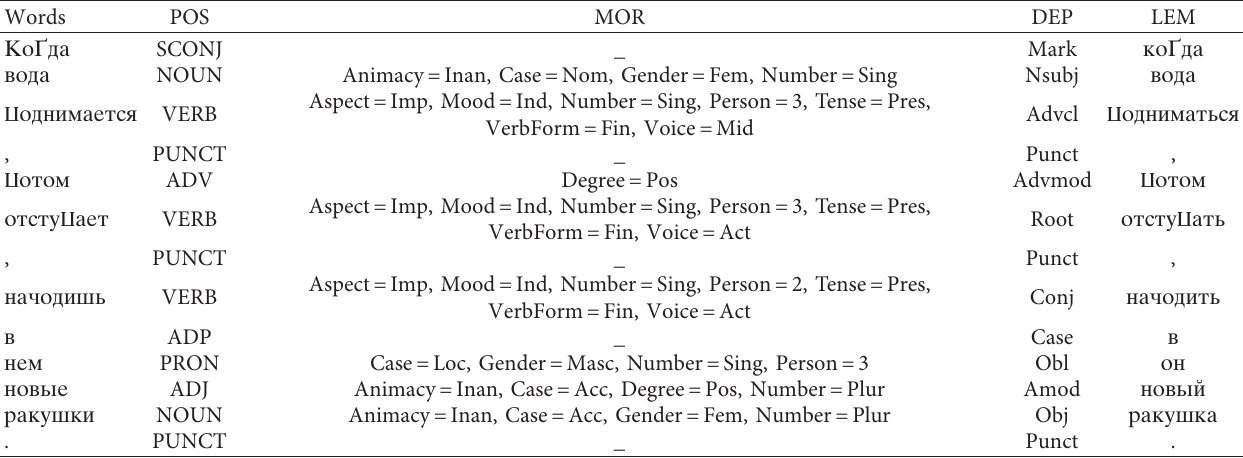
Table 1: A short Russian sentence with its corresponding sequence of linguistic features.